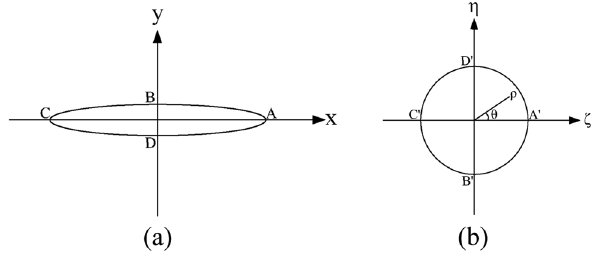
Figure 6: Diagram of plane projection: ( a ) plane z and ( b ) plane ζ .